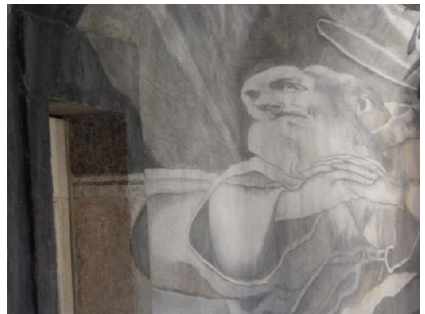
Fig. 18a fresco at Trinità dei Monti convent, Rome